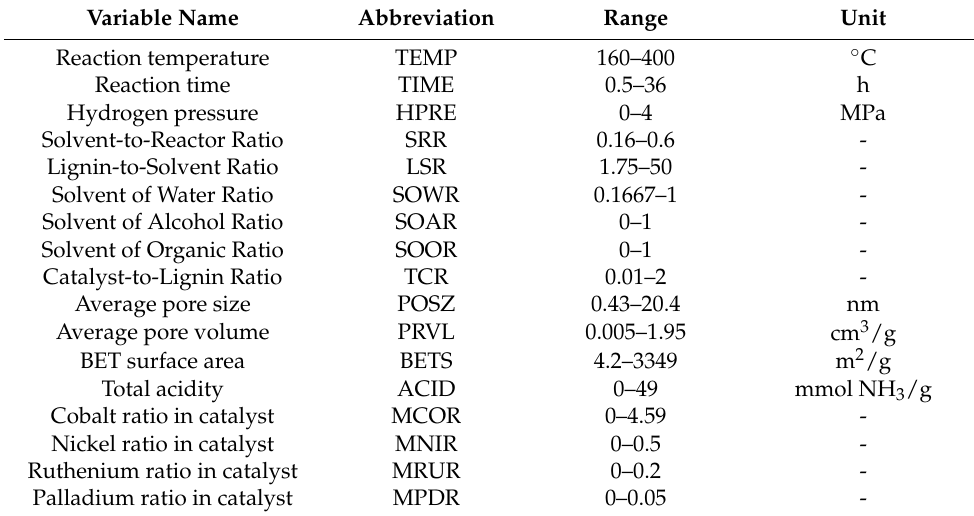
Table 2. Variables and their abbreviations that applied in this